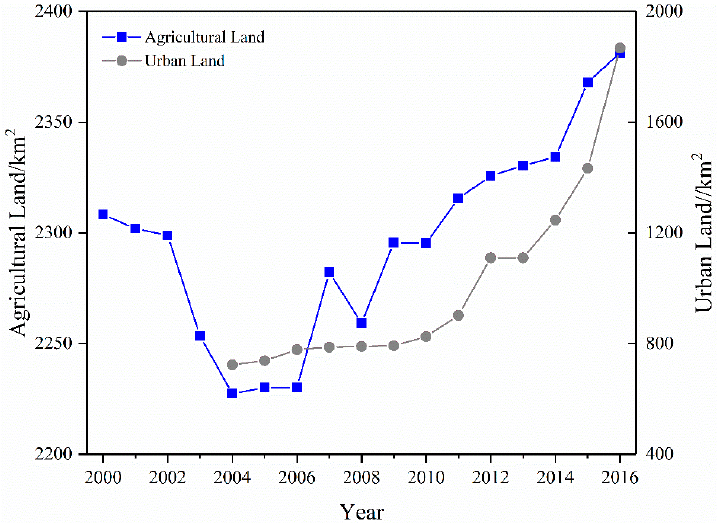
Figure 9. The inter-annual variation of the agricultural land area from 2000 to 2016 in the Tibet Autonomous Region.